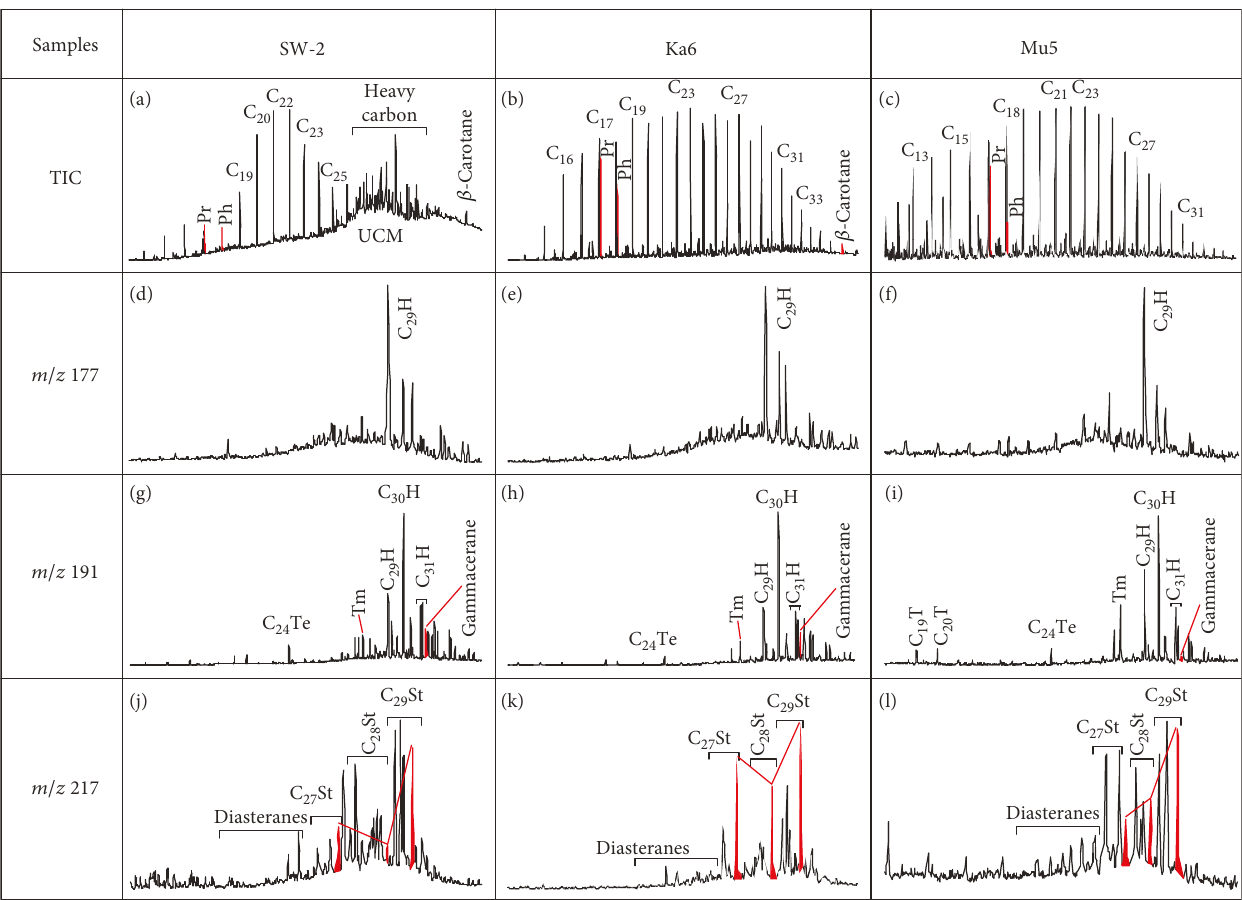
Figure 6: Selected molecular geochemical chromatograms of oil-seep and crude-oil samples from the western segment of southern Junggar Basin. See Figure 4 for the